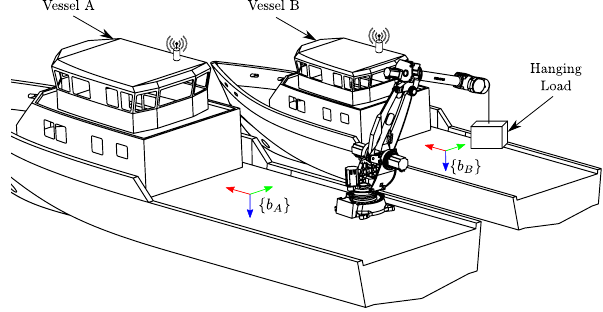
Figure 1: The VVMC problem where a load is sup- posed to be transported from vessel/ship A onto vessel/ship